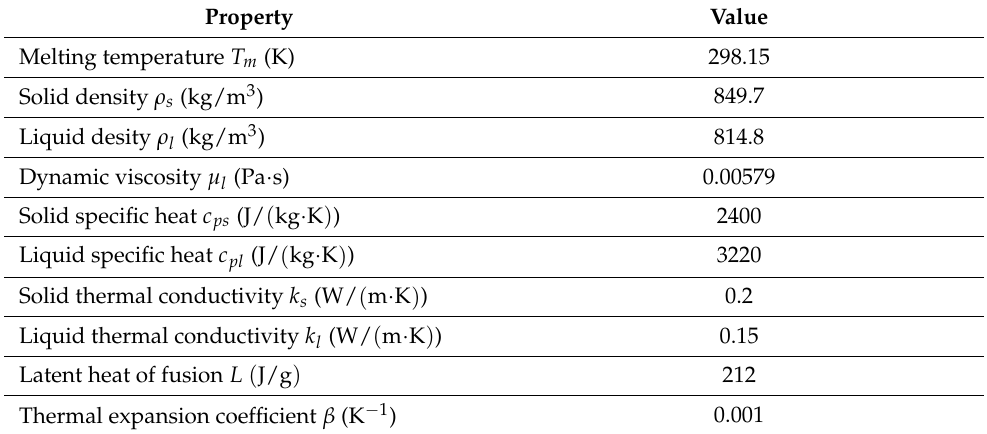
Table 1. Thermo-physical properties of paraffin wax